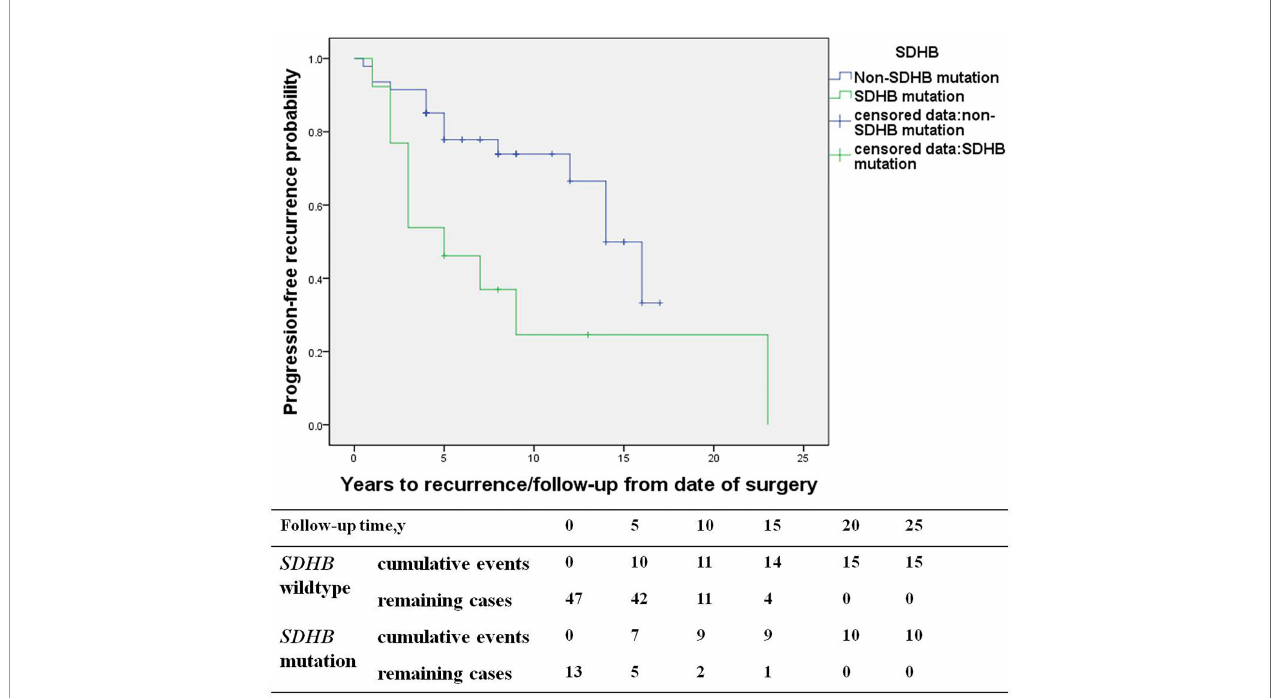
FIGURE 4 | The recurrence-free survival ( SDHB mutation patients versus SDHB wildtype patients) in paraganglioma patients.